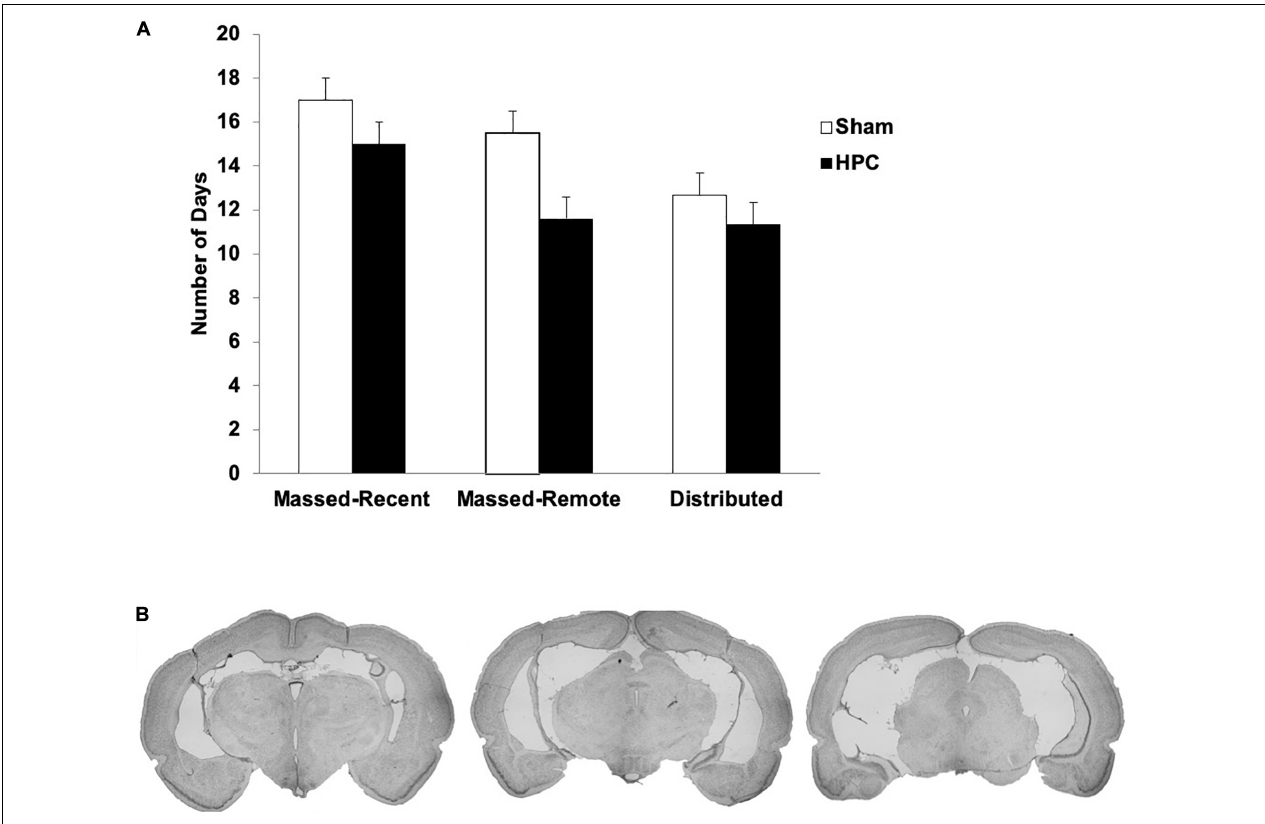
FIGURE 2 | (A) Mean (+SEM) number of days to reach the learning criterion pre-surgically for Sham and HPC rats in the massed/recent, massed/remote, and distributed conditions. No statistical differences were found across groups, suggesting equivalent learning of the visual discrimination prior to the rats being given their overtraining trials. (B) Photomicrographs of coronal brain sections of a lesion rat that sustained 88.1% damage to the HPC. This lesion is representative of the average lesion size for rats across all experiments. Note that the lesions were made after criterion learning and the overtraining trials.